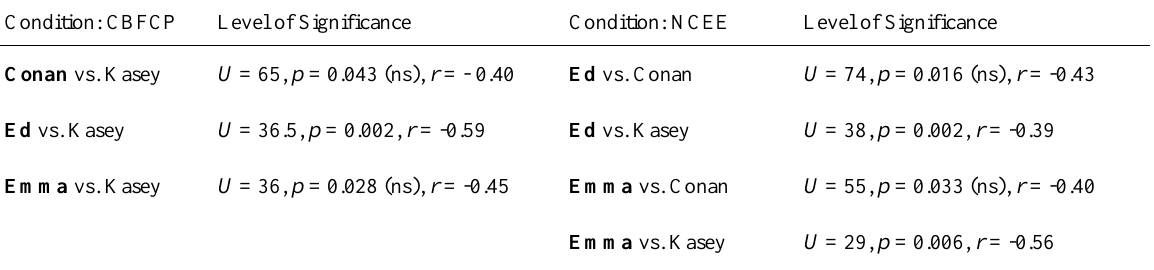
Stage 1 Results of Mann-Whitney Tests: Group Comparisons that Produced Significant Results 1,2 Condition: